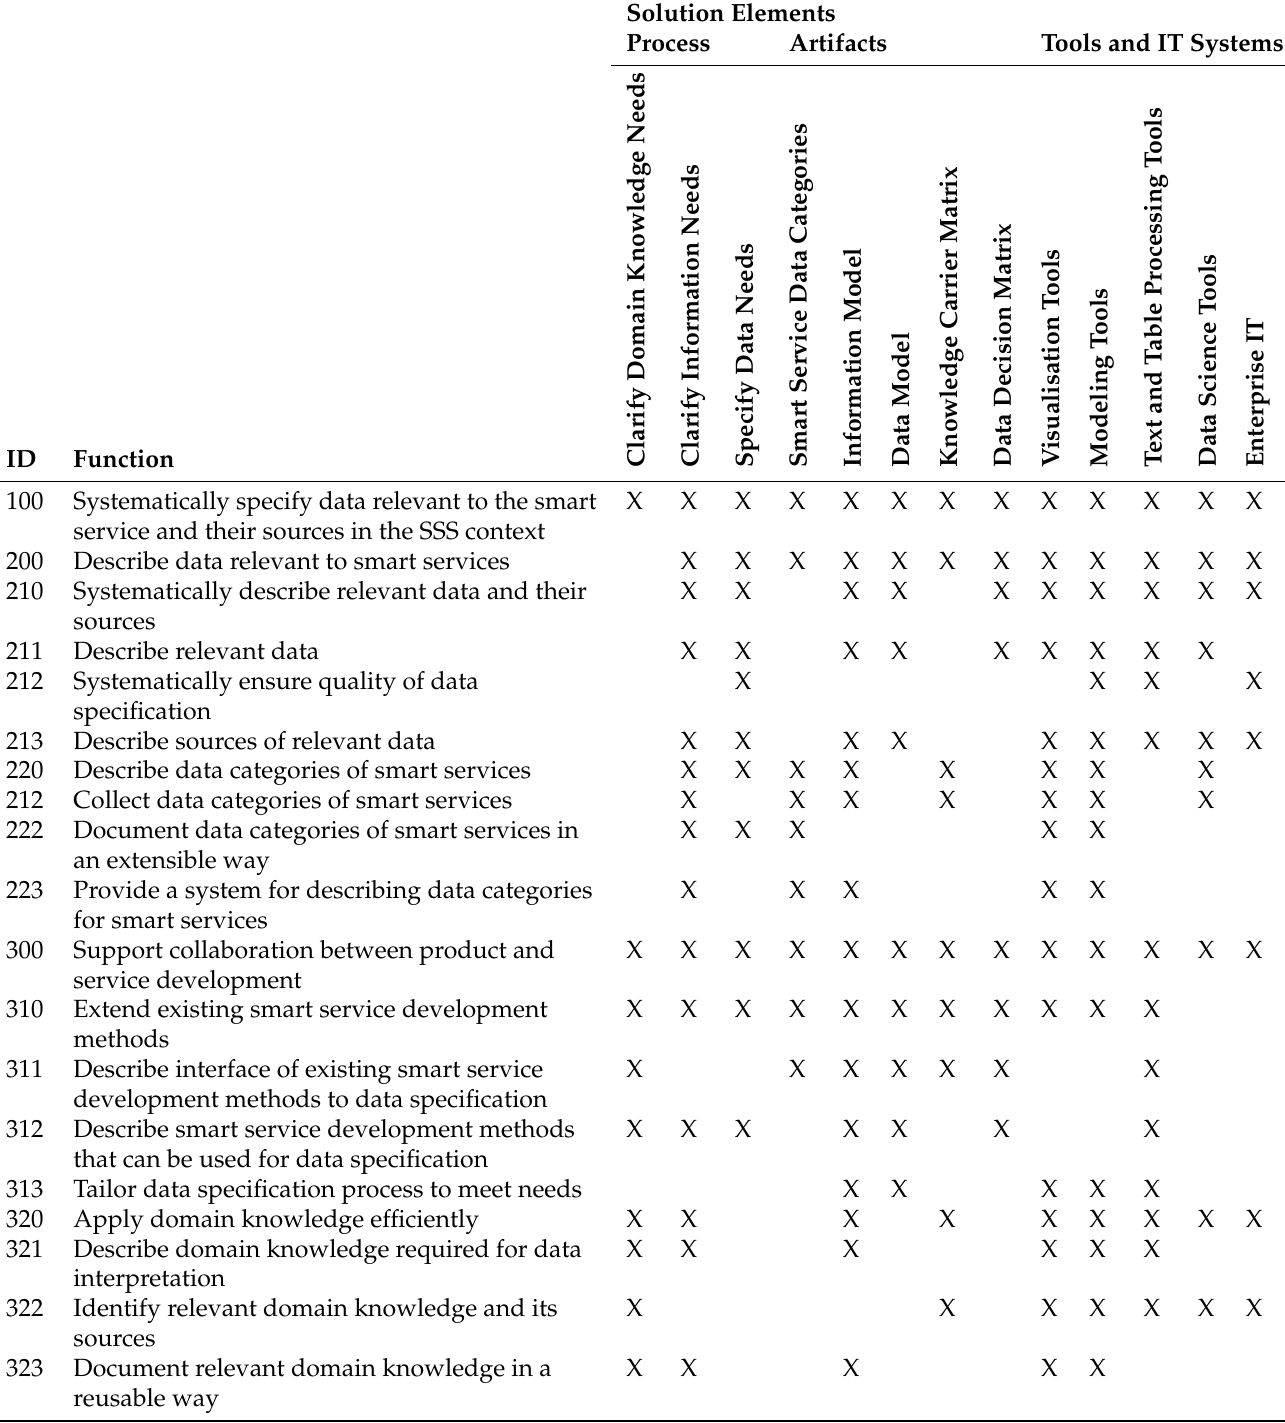
Table A5. Mapping of functions and SemDaServ solution